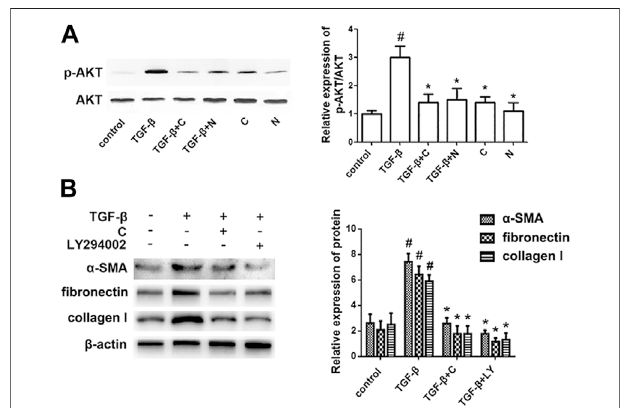
FIGURE6| Treatmentwithchloroquinesuppressed theactivationofthe AKT pathway (A) Treatment with chloroquine suppressed the TGF- β 1- induced phosphorylation of AKT in ASM cells. The phosphorylation and total protein content of AKT were measured by western blot. The relative density quanti fi cation was phosphorylated proteins relative to total proteins (B) The contents of α -SMA, fi bronectin and collagen I were measured by western blot. Values are the mean ± SEM of at least four independent experiments performed intriplicate. # p < 0.05 compared withthecontrol, and * p < 0.05 compared with the TGF- β 1 group. C, chloroquine (5 μ m); TGF- β , TGF- β 1 (5 ng/ml); N, NAC (10 mm); LY, LY294002 (10 μ m).